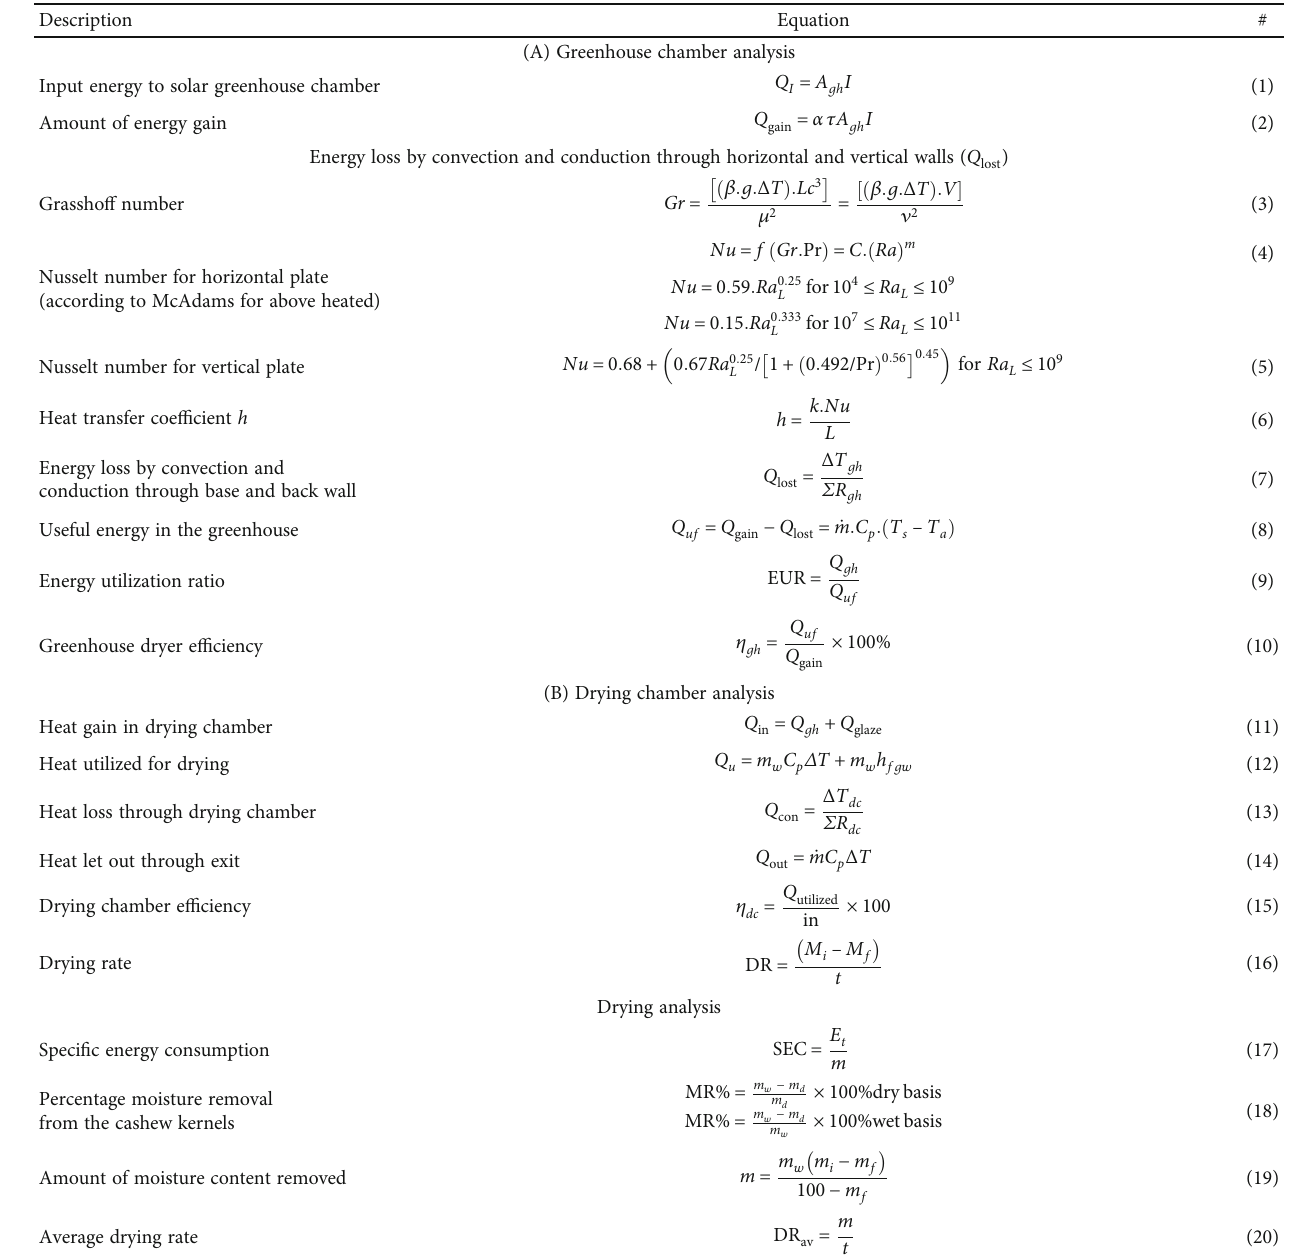
Table 1: Empirical relations used for the thermal analysis.